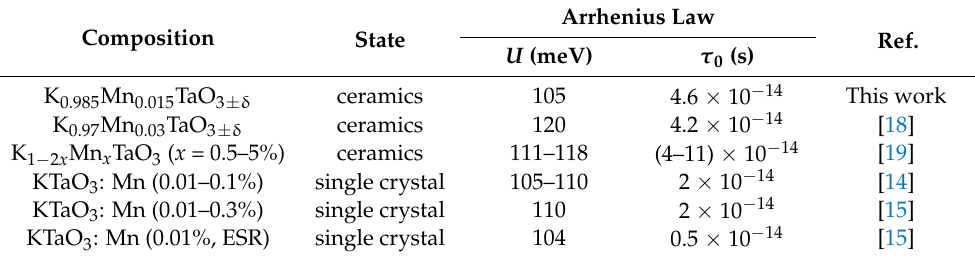
Arrhenius Law Ref. U (meV) τ 0 (s)